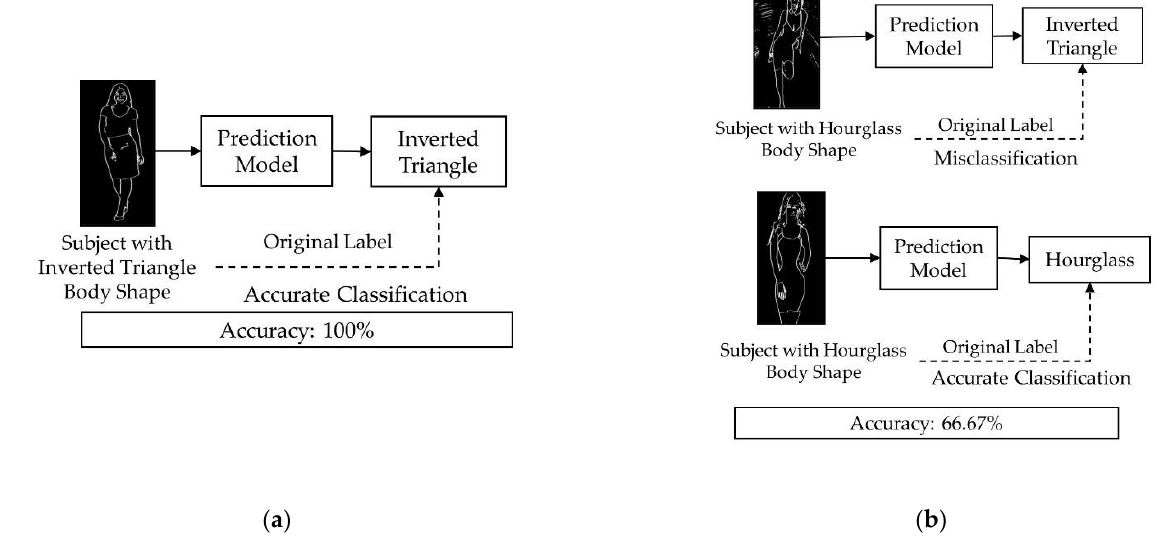
Figure 15. Prediction accuracy for the example of 2 body shape types using k-NN classifier with bag-of-features: ( a ) inverted triangle and ( b ) hourglass. Table 2. Confusion matrix for the classification of 4 body shapes using the k-NN classifier with the bag-of-features.